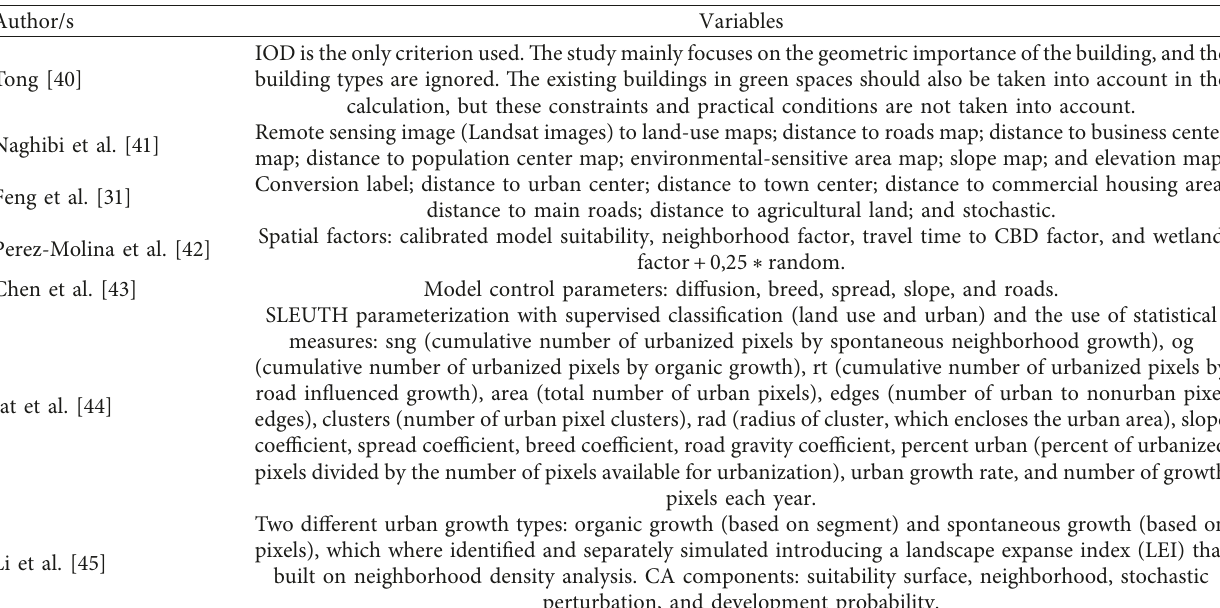
Figure 8: Genetic algorithm prognostications on a probabilistic grayscale in Tokyo’s Minato district. Darker tones indicate a greater probability of new high-rise advancements (130m approximately). Dots constitute discharge structures already planned for completion between 2016 and 2019 [49]. Table 2: Variables used for prediction in the articles of this